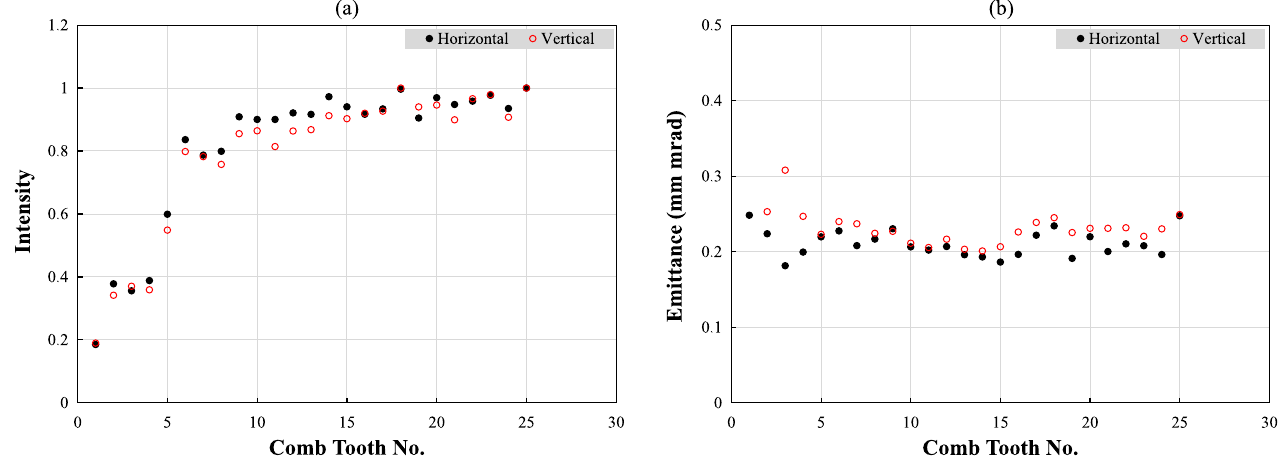
FIG. 14. Calculated beam parameters from the emittance data in Fig. 13. (a) Normalized intensities. (b) Emittance